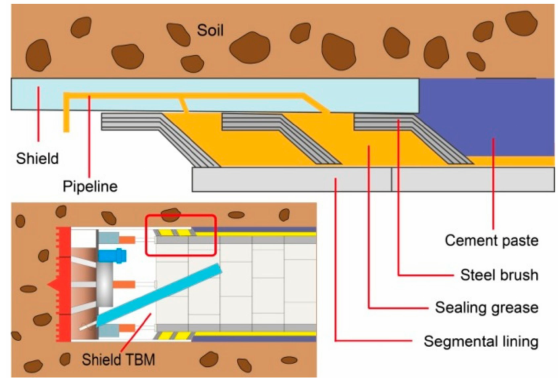
Figure 1. Schematic diagram of tail sealing for a shield